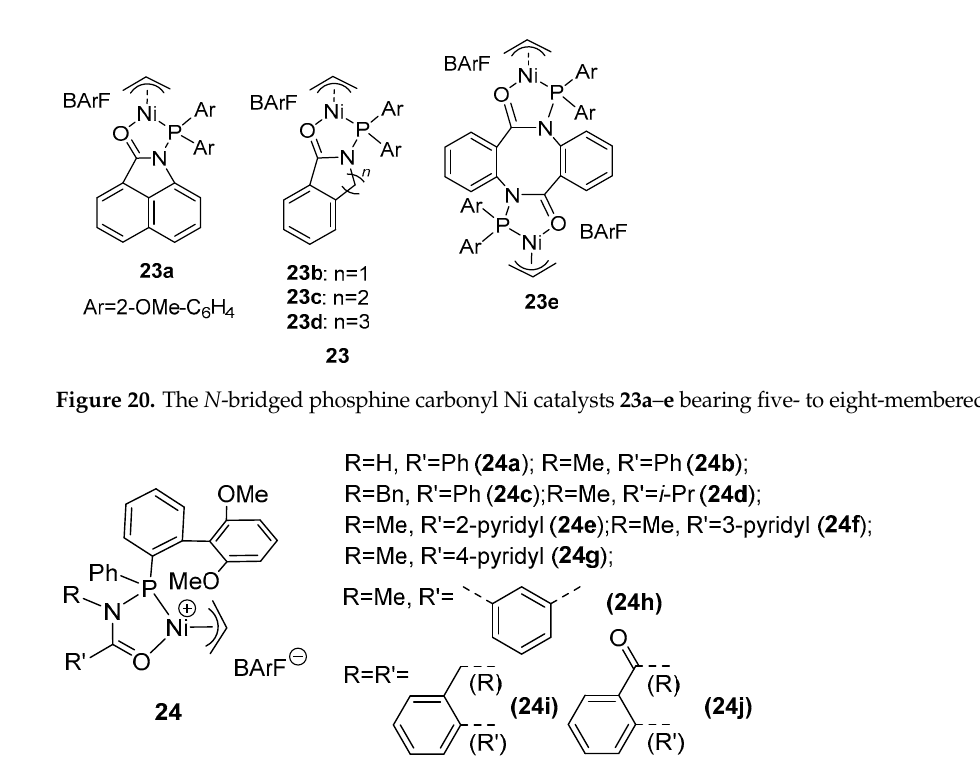
Figure 21. Cationic phosphine carbonyl nickel catalysts 24a – j bearing various substituents on the 4ligand backbone.